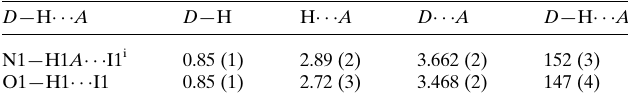
Table 1 Hydrogen-bond geometry (A˚ , (cid:4) ).